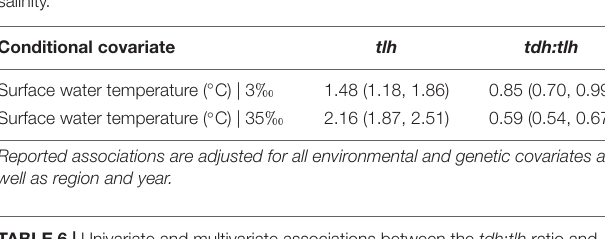
TABLE 6 | Univariate and multivariate associations between the tdh : tlh ratio and environmental/genetic covariates based on linear combinations of seemingly unrelated